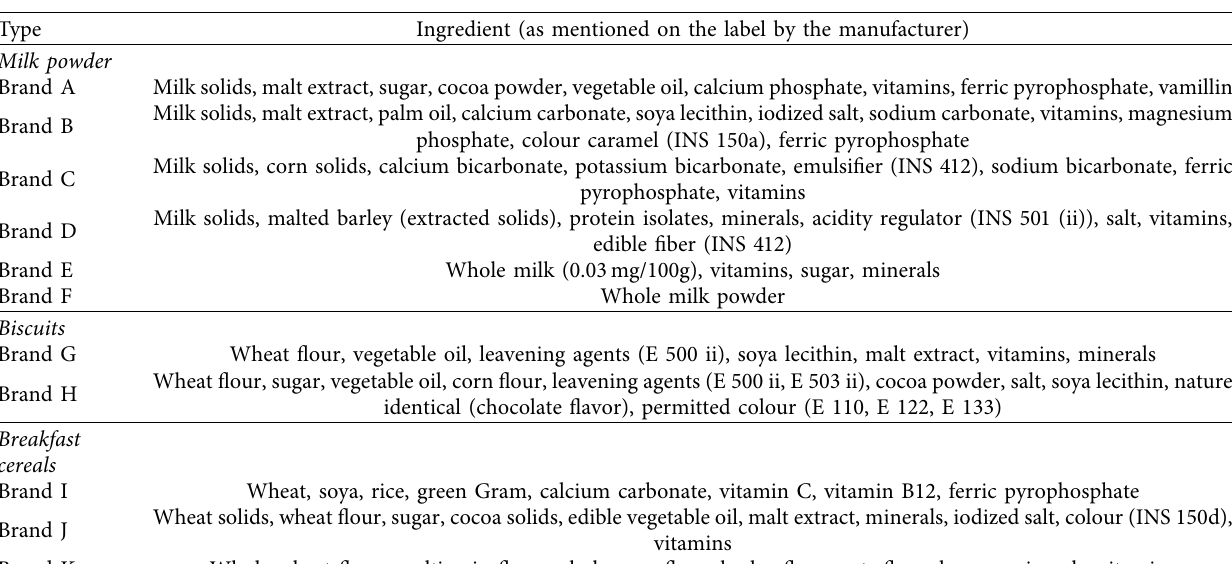
Table 3: Added ingredients to produce each food product by the manufacturer (based on the labeled information). Type Ingredient (as mentioned on the label by the manufacturer)